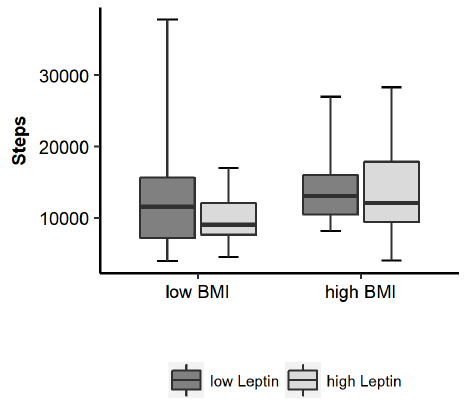
Figure 2. Steps in groups with high and low BMI and high and low leptin (median split).